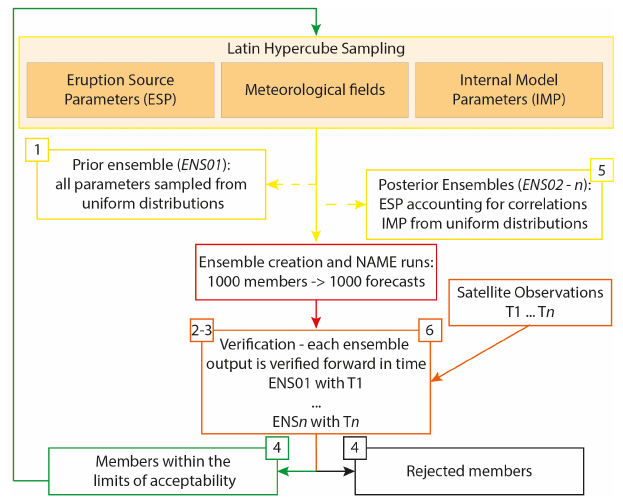
Figure 2. Overall workflow of the particle filtering methodology.